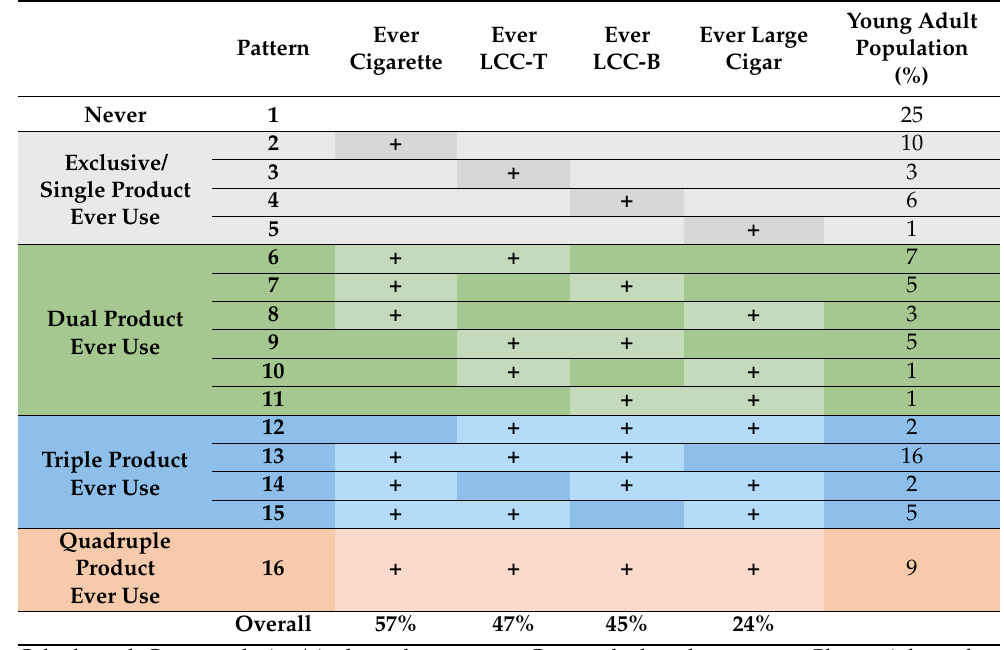
Table 2. Ever Poly-Tobacco Product Use Young Adults ( n = 1063), Weighted to U.S.-Representative